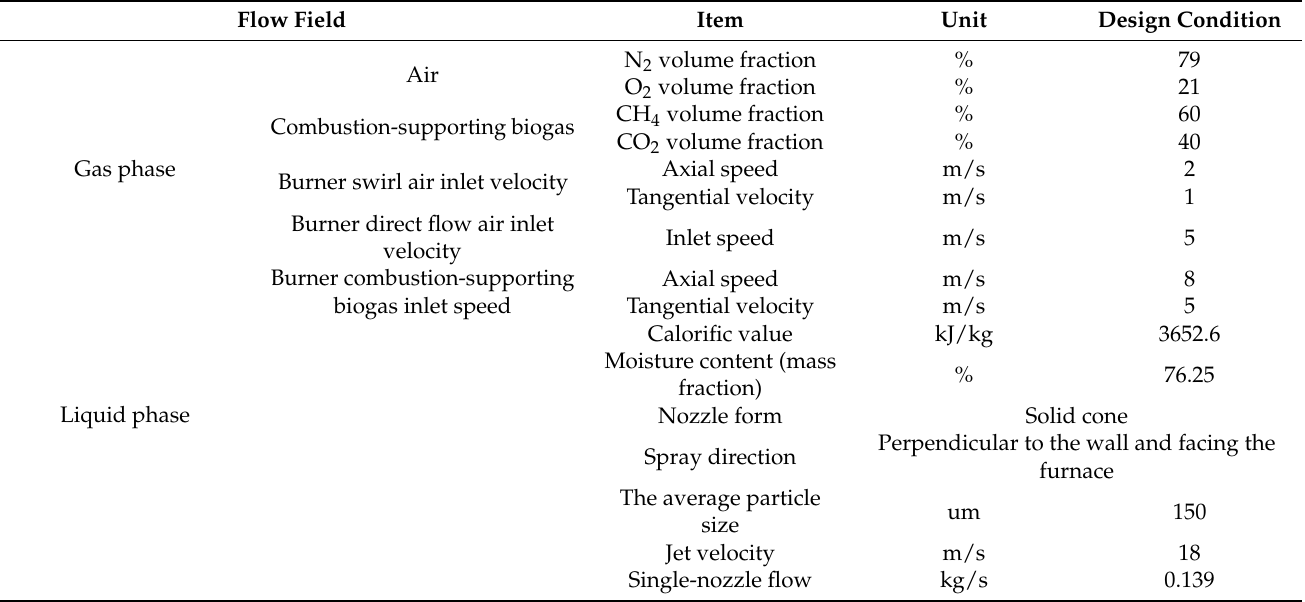
Table 1. Gas–liquid two-phase flow